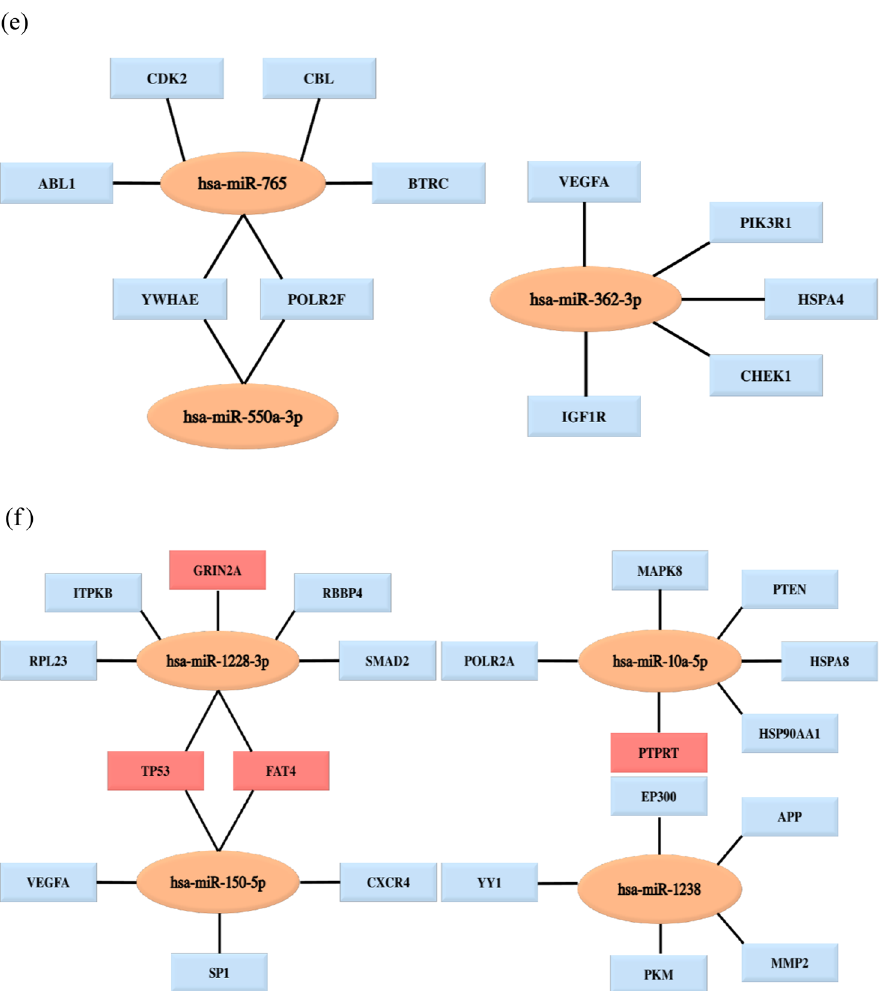
Figure 5: Analysis of the PPI network and the miRNA target network. ( a ) The mapped networks for the top 25 hub genes for upregulated miRNAs. ( b ) The mapped networks for the top 25 hub genes for downregulated miRNAs. ( c ) The mirDIP analysis of interaction levels between hub genes and DE - miRNAs. ( d ) The mirDIP analysis of interaction levels between the main mutated genes and DE - miRNAs. ( e ) The mapped networks for upregulated miRNAs and hub genes. ( f ) The mapped networks for downregulated miRNAs and hub genes. The red gene indicates that it is both a mutant gene and a core